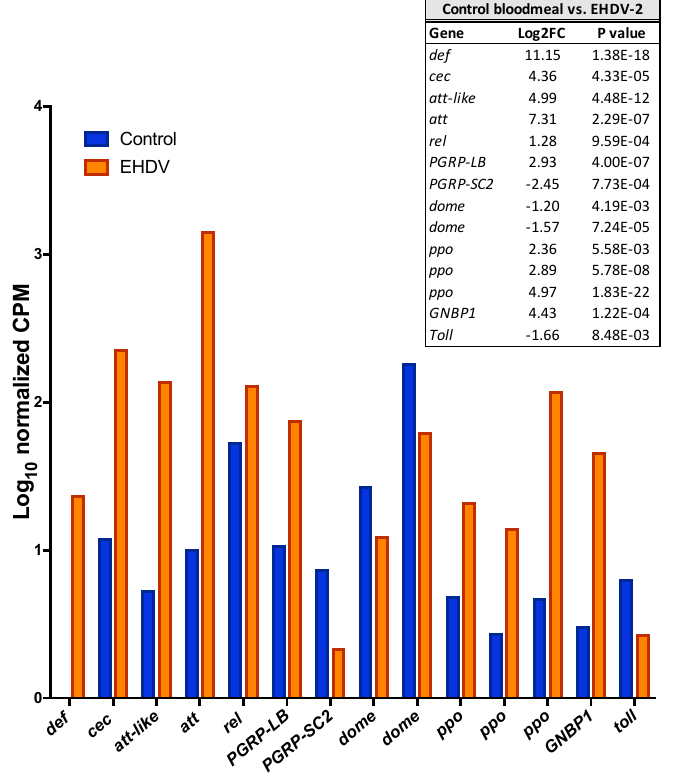
Figure 2. Innate immune genes that were di ff erentially-expressed after EHDV-2 infection in the midge. Control midges were fed blood with sterile virus media and EHDV-2 midges were fed blood with virus in media ( n = 15 per replicate, 2 replicates). Data were captured at 36 h post-ingestion for whole midges. 10-log CPM (Counts Per Million mapped reads) represents relative expression across conditions (normalized for two replicates). All unigenes shown were differentially expressed between the two conditions ( p < 0.05). Log 2 FC and actual p values are shown in inset table with further details between the two conditions available in Table S2. def, defensin (m.9997); cec, cecropin (m.10000); att-like,